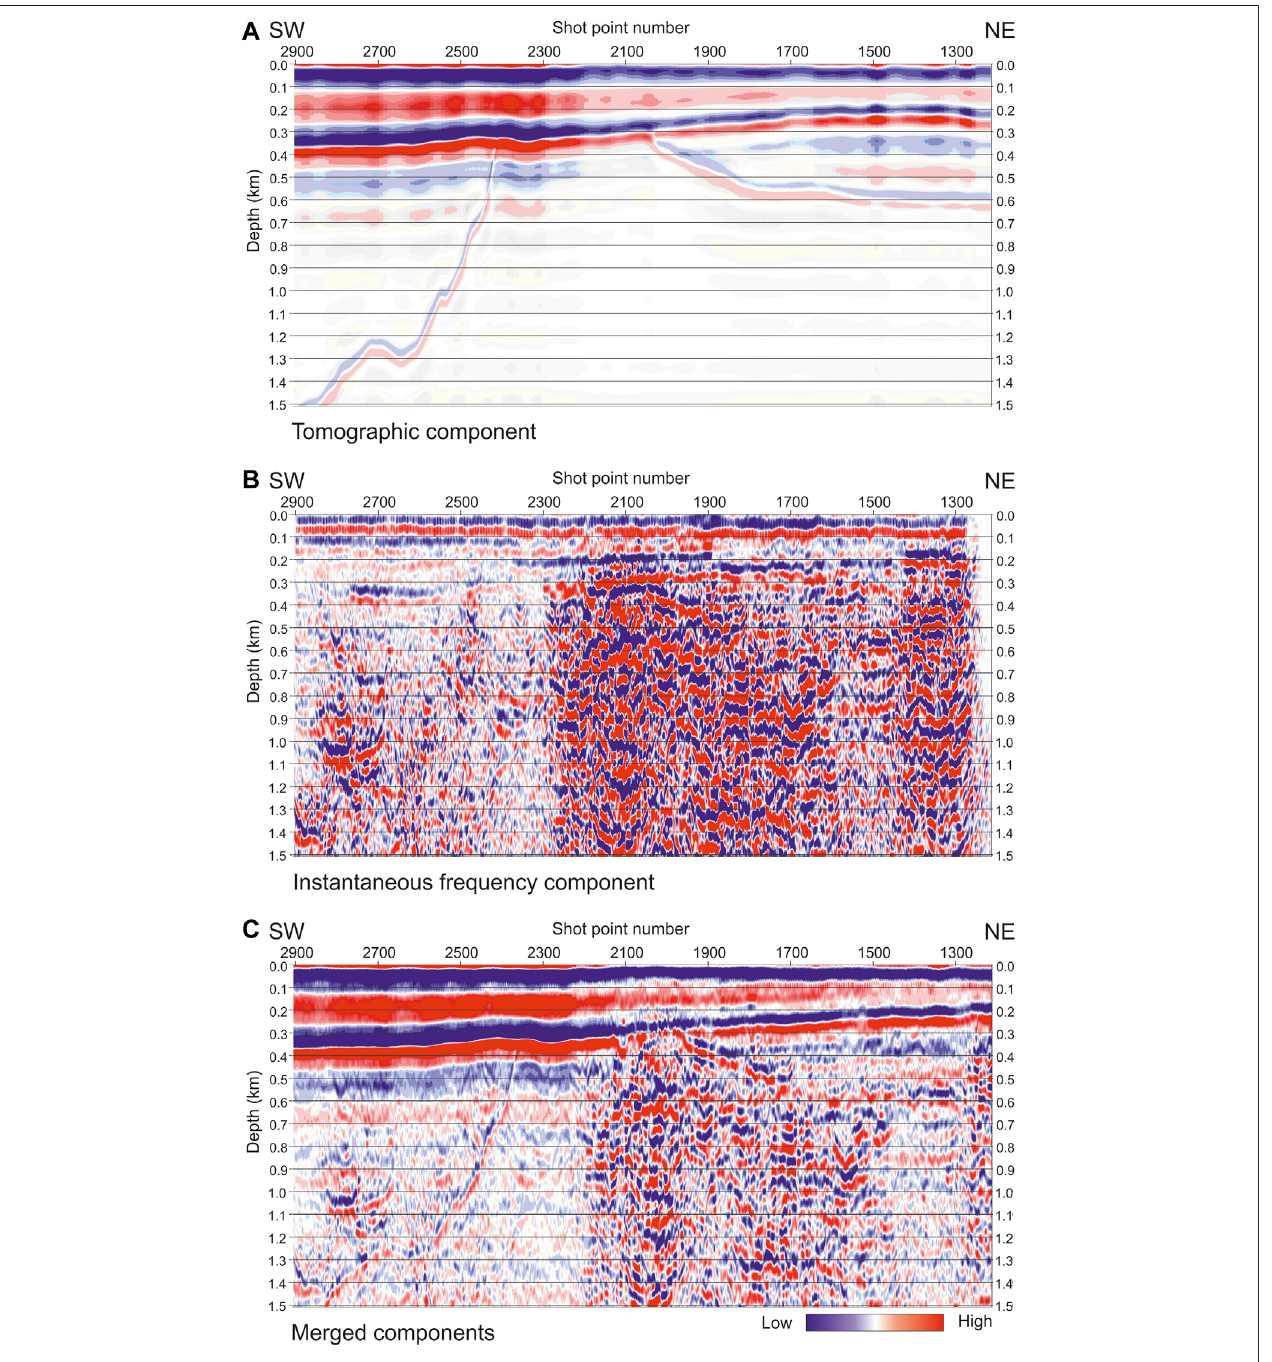
FIGURE13| Componentsoftheestimatedanelasticabsorptionfromtomography(top)andinstantaneousfrequency(center)inthefrequencybandde fi nedbythe Ormsby fi lter with corner frequencies 3,4,16, and 20 Hz, and their combination (bottom), obtained by normalizing and averaging their amplitude spectra.